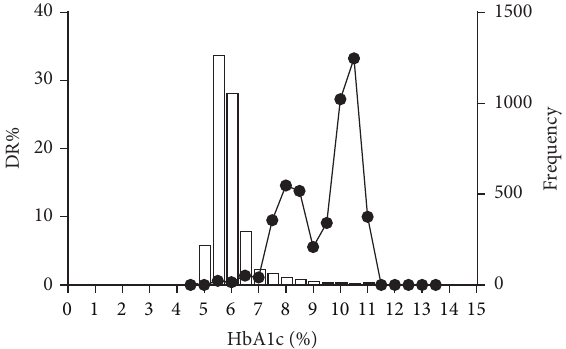
Figure 1: Distribution of fasting plasma glucose (FPG) and the corresponding prevalence of diabetic retinopathy (DR) in the study population.